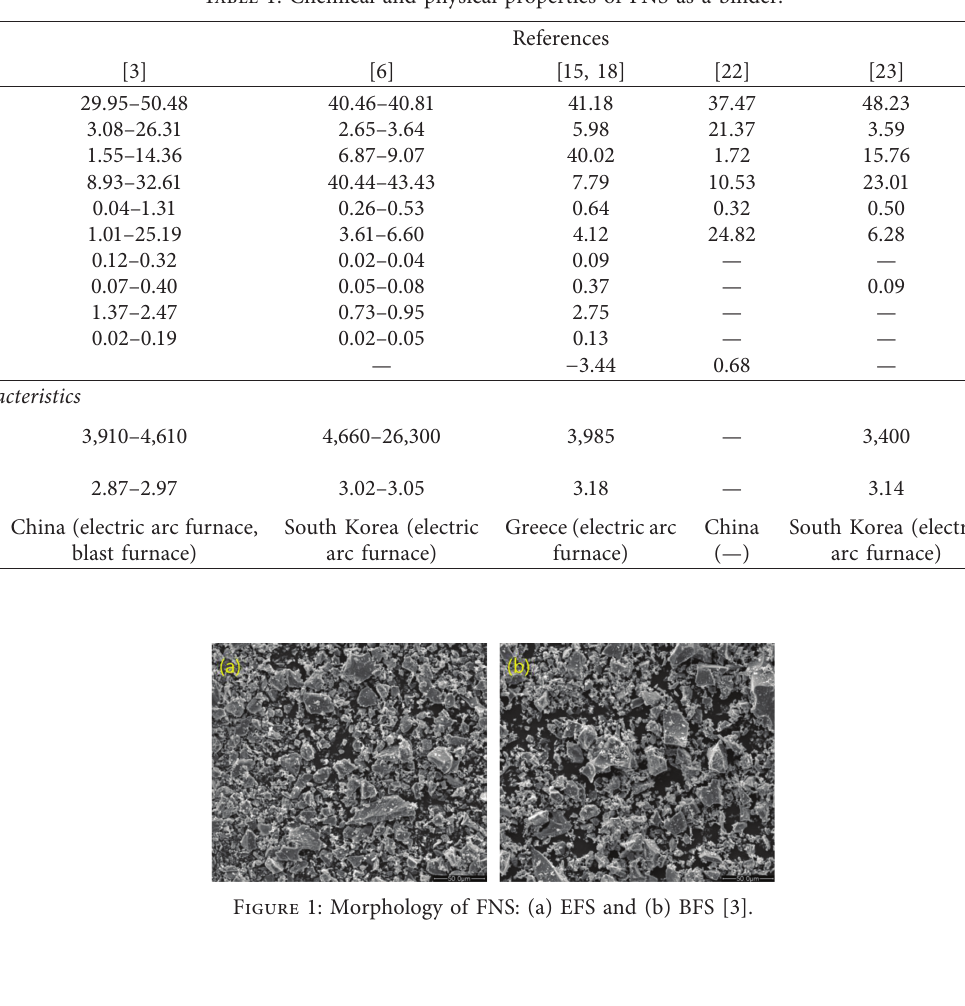
Table 1: Chemical and physical properties of FNS as a binder.